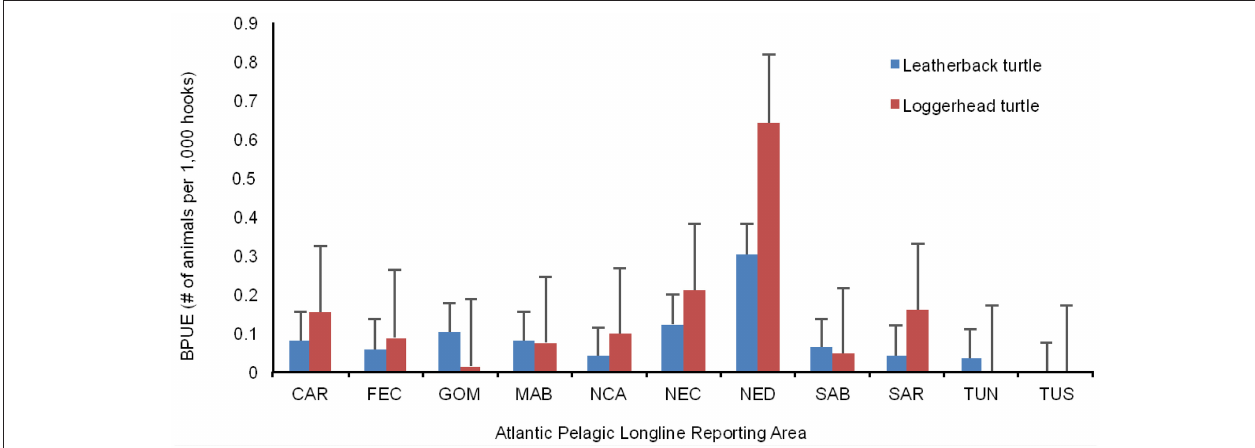
FIGURE 2 | Atlantic data. Mean turtle BPUE (# individuals caugh per 1,000 hooks ± SD) by statistical reporting area. CAR, Caribbean; GOM , Gulf of Mexico; FEC, Florida East Coast; MAB, Mid-Atlantic Bright; NCA , North Central Atlantic; NEC, Northeast Coastal; NED, Northeast Distant; SAB, South Atlantic Bight; SAR Sargasso; TUN, Tuna North and TUS, Tuna South.